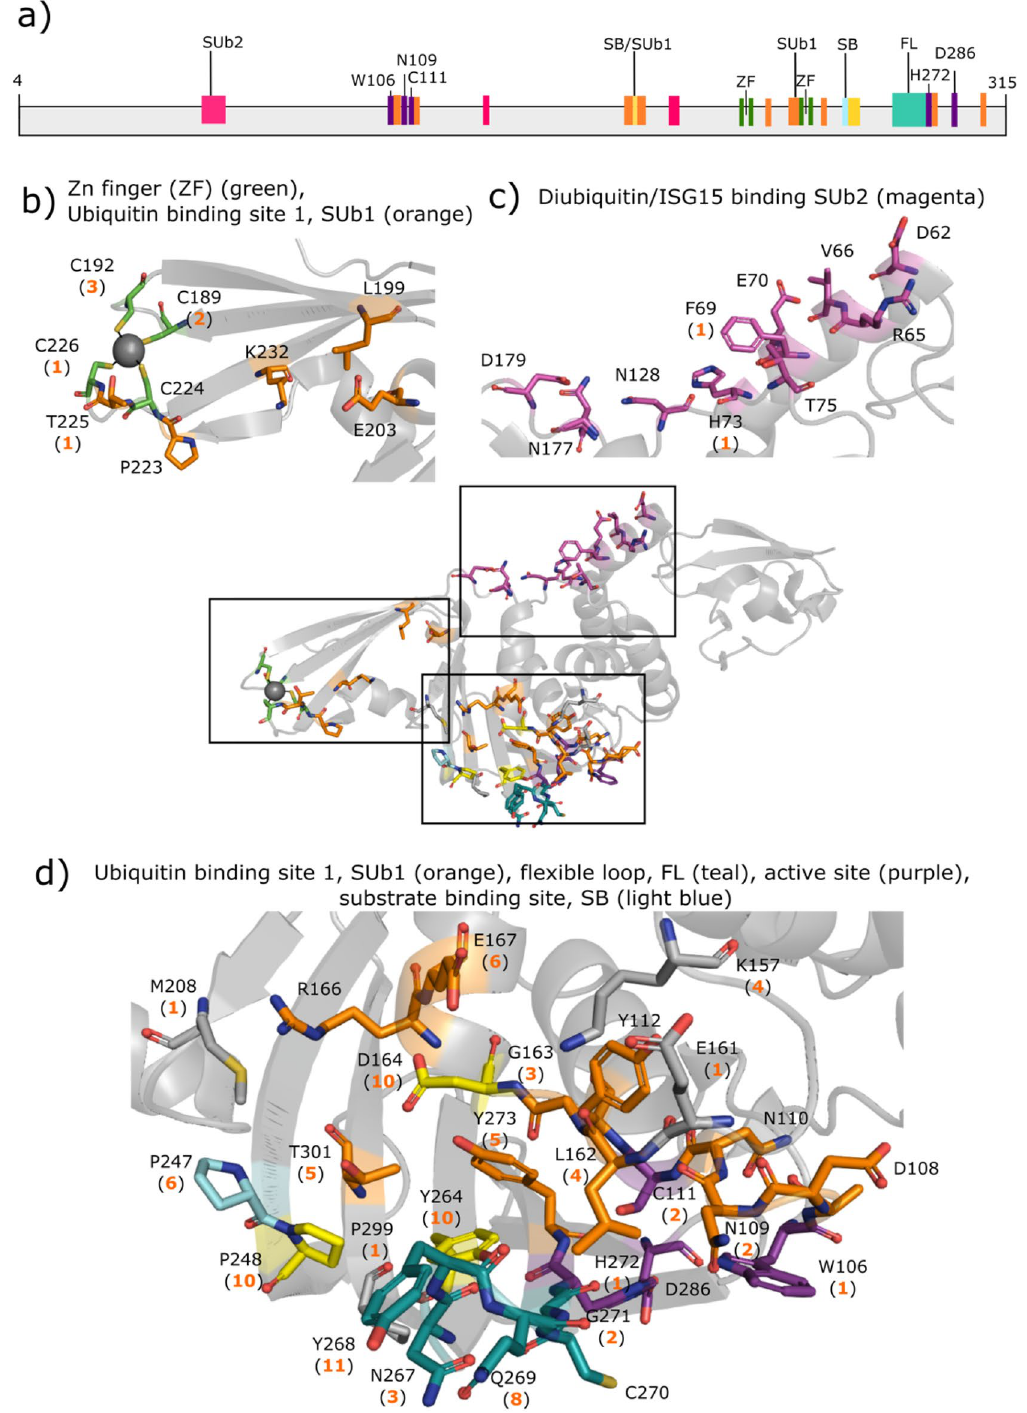
Figure 3. SARS-CoV-2 PL pro domain structure and binding sites. ( a ) Diagram showing the active-site catalytic residues (W106, C111, H272, D286 in purple), the substrate-binding residues (SB, light blue), residues 267–271 in the flexible loop (FL, teal), residues in the SUb1 (orange) and SUb2 (magenta) subsites, and residues shared by the active-site cleft and the SUb1 subsite (yellow). The 1.90-Å crystal structure of apo PL pro (PDB 7d7k) 28 and the number of drugs (in parentheses) targeting residues in the Zn 2+ -binding site ( b ), the SUb2 subsite ( c ), and the active site, which overlaps with the SUb1 subsite ( d